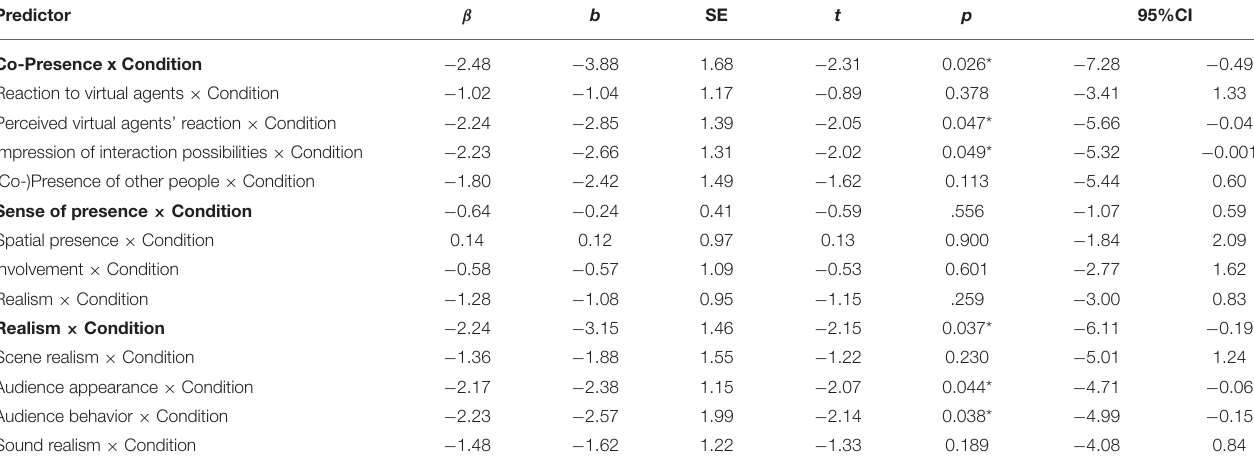
TABLE 3 | Interaction between subjectively assessed VR characteristics and the presence of agents on